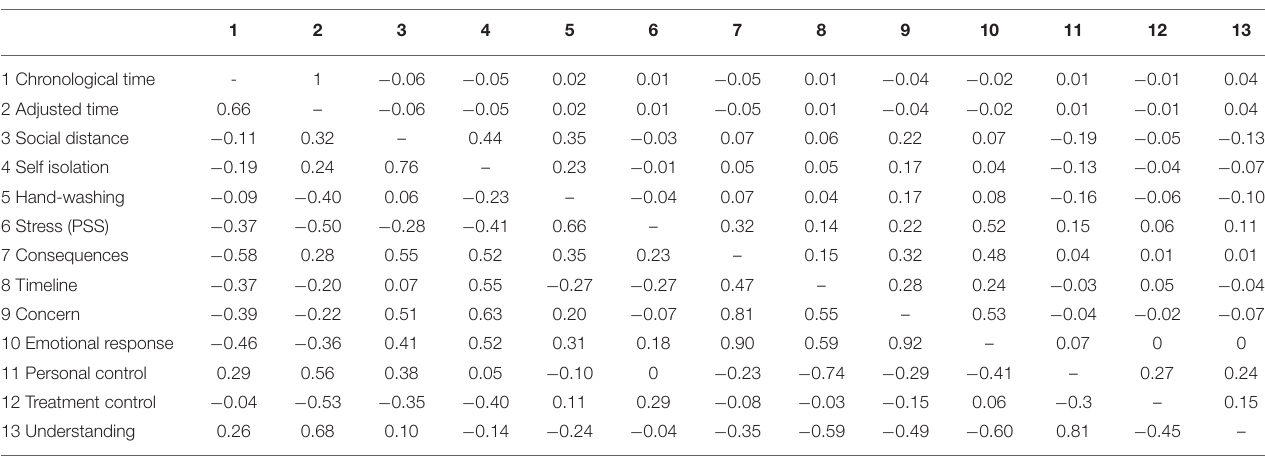
TABLE 2 | Multilevel correlations between illness perceptions, preventive behaviors, and